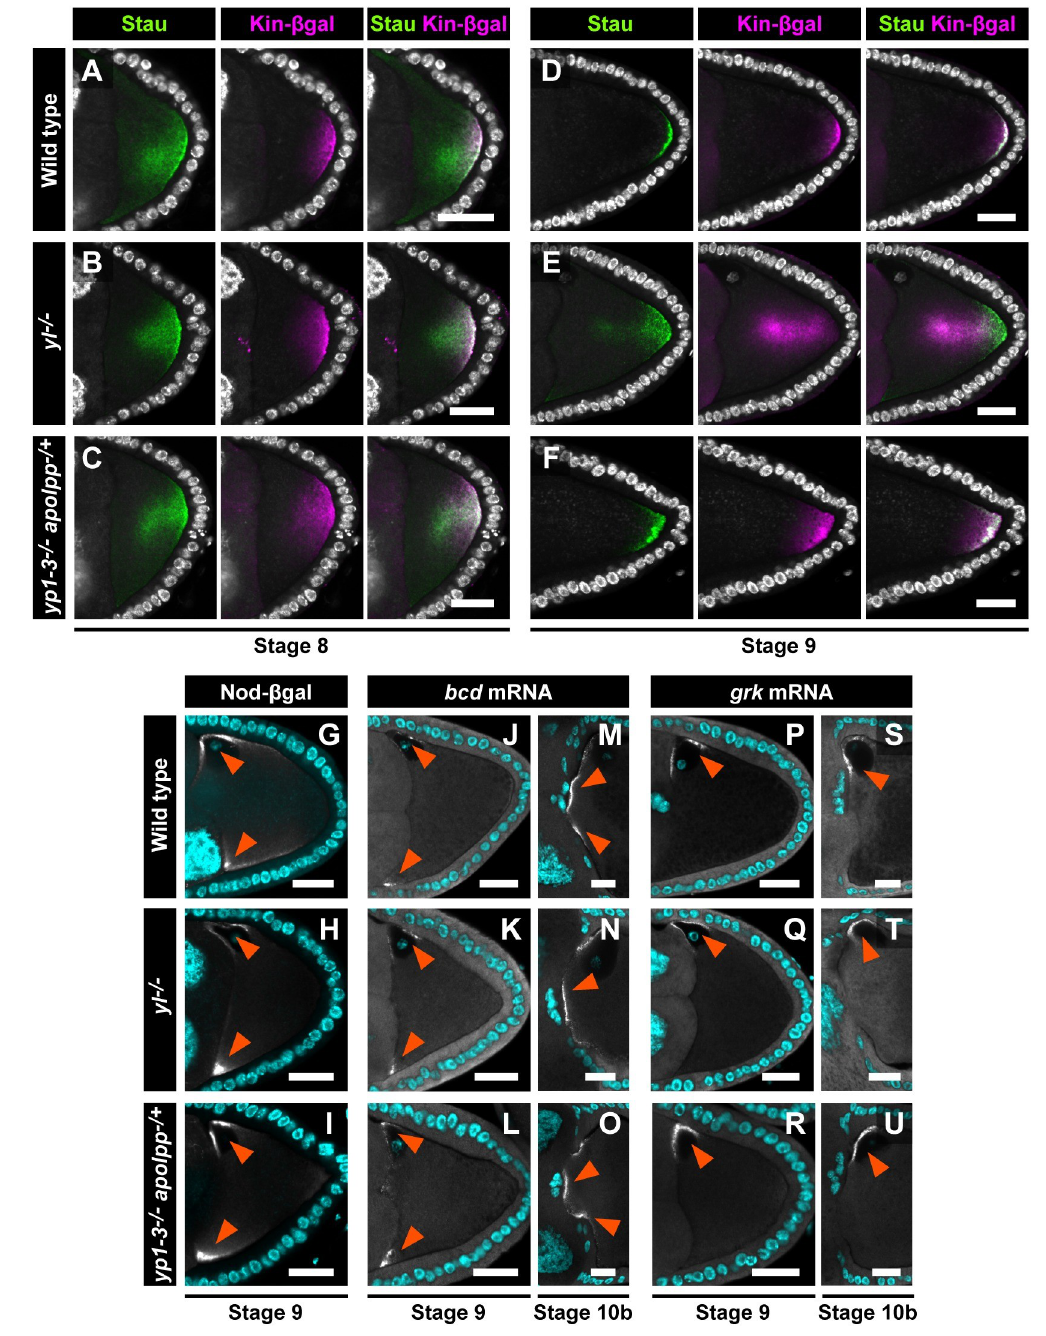
Fig 3. Yl and its ligands are required for microtubule-dependent localization of osk mRNA to the oocyte posterior cortex. (A– F) Localization of Stau and Kin- β gal in stage 8 and stage 9 oocytes in wild-type (A, D), yl −/− (B, E), and yp1–3 −/− apolpp −/+ (C, F) ovaries. DNA stained with DPAI is shown in white. The microtubule plus-end marker Kin- β gal was accumulated at the posterior pole in yl −/− and yp1–3 −/− apolpp −/+ oocytes at stage 8 (A–C). However, its localization to the posterior pole was not maintained in stage 9 yl −/− and yp1–3 −/− apolpp −/+ oocytes (D–F). Localization of Stau was also disrupted. (G–I) Localization of Nod- β gal in stage 9 oocytes in wild-type (G), yl −/− (H), and yp1–3 −/− apolpp −/+ (I) ovaries. DNA stained with DPAI is shown in cyan. (J–U) Localization of bcd (J–O) and grk mRNAs (P–U) in stage 9 or stage 10b oocytes in wild-type (J, M, P, S), yl −/− (K, N, Q, T), and yp1–3 −/− apolpp −/+ (L, O, R, U) ovaries. DNA stained with DPAI is shown in cyan. Localization of bcd and grk mRNA was intact in yl −/− and yp1–3 −/− apolpp −/+ oocytes (arrowheads). Scale bars: 20 μ m. Kin- β gal, Kinesin- β -galactosidase; Stau, Staufen; Yl,